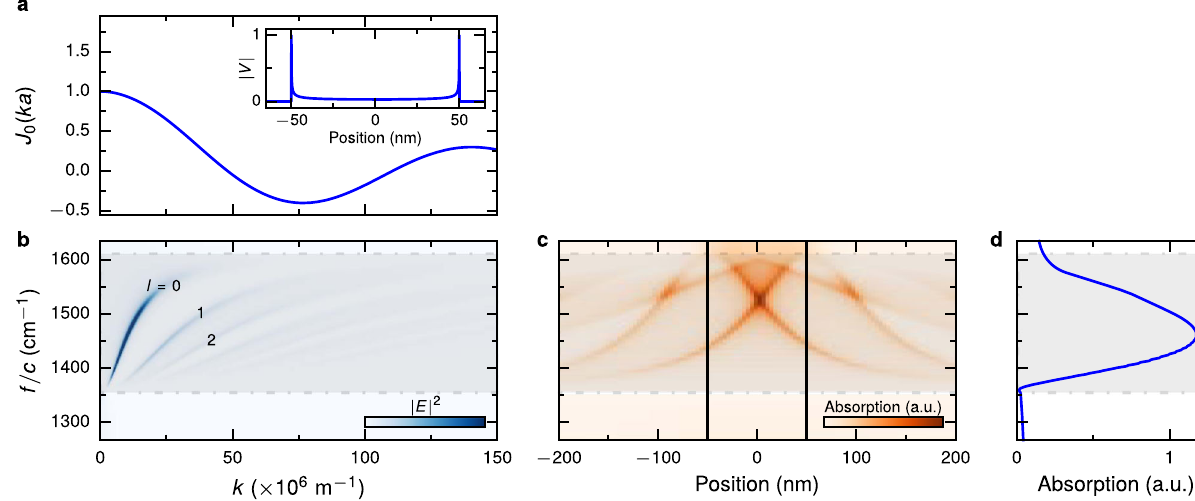
Fig. 3 Analytic calculation of absorption spectra. a Momentum distribution provided by a metallic split gate with 100 nm gap width. The associated electric fi eld pro fi le is shown in the inset. b HPP frequency dispersion curves showing discrete eigenmodes l = 0, 1, 2, … calculated for the full system of a metal gate, 50 nm h-BN, graphene and 55 nm h-BN on top . c Real space absorption pro fi le obtained from the analytic calculations. d The resulting absorption spectrum calculated in k -space of the total power absorbed inside the graphene